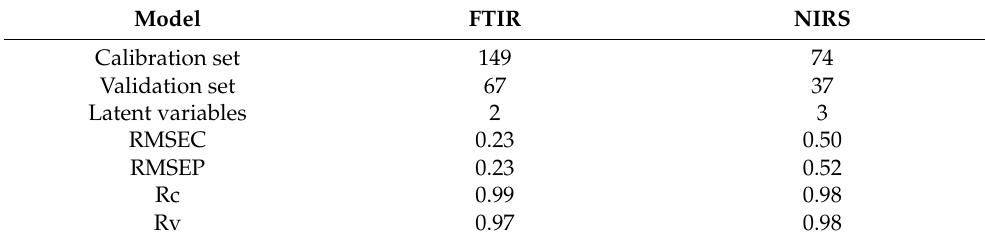
Table 1. Comparison of the PLS models for both FTIR and NIR techniques. Model